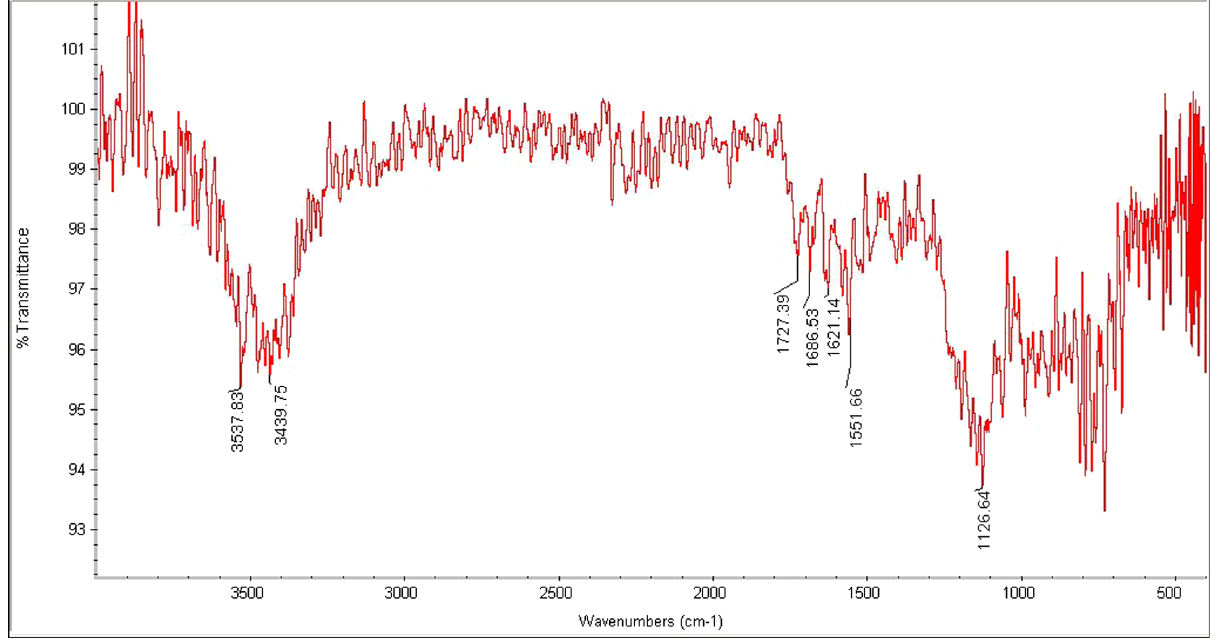
Figure 1: FTIR spectra of the carbon nanotube functionalized with tobacco